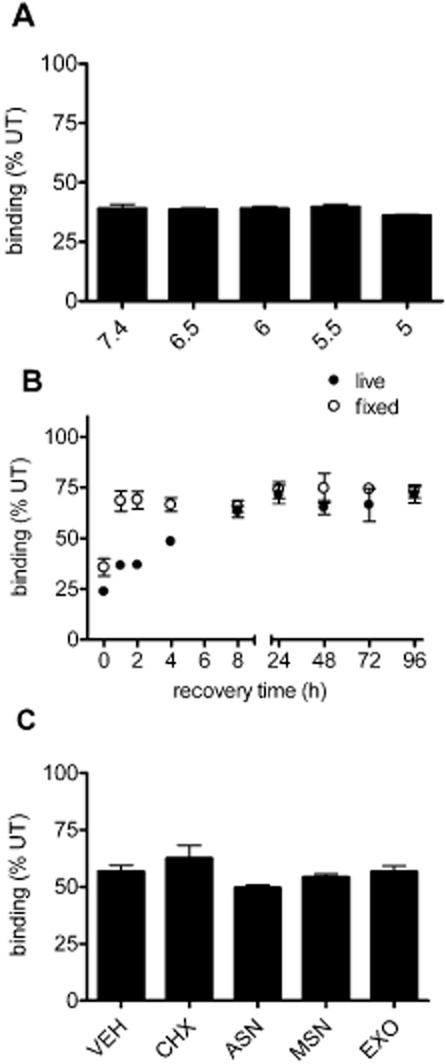
Recovery of 5-HT3 receptor binding sites following palonosetron exposure. (A) Cells were incubated with palonosetron (1 nM) for 150 min at 4°C, and then washed in acidic buffer (at indicated pH), prior to [3H]granisetron binding (performed at pH 7.4). (B) Following palonosetron exposure (1 nM, 150 min, 37°C) in either live or fixed cells, recovery of 5-HT binding sites was monitored over time (0–96 h) using [3H]granisetron binding and related to the level of binding sites in untreated (UT) cells. (C) Cells were allowed to recover for 8 h after removal of palonosetron in the absence (0.1% ethanol vehicle, VEH) or presence of cycloheximide (CHX, 35 μM), anisomycin (ASN, 10 μM), monensin (MSN, 5 μM) or Exo-1 (EXO, 50 μM). Radioligand binding signal is expressed as a % of control cells that were treated with inhibitor or vehicle but not exposed to palonosetron. Data are average of three independent experiments performed in triplicate.